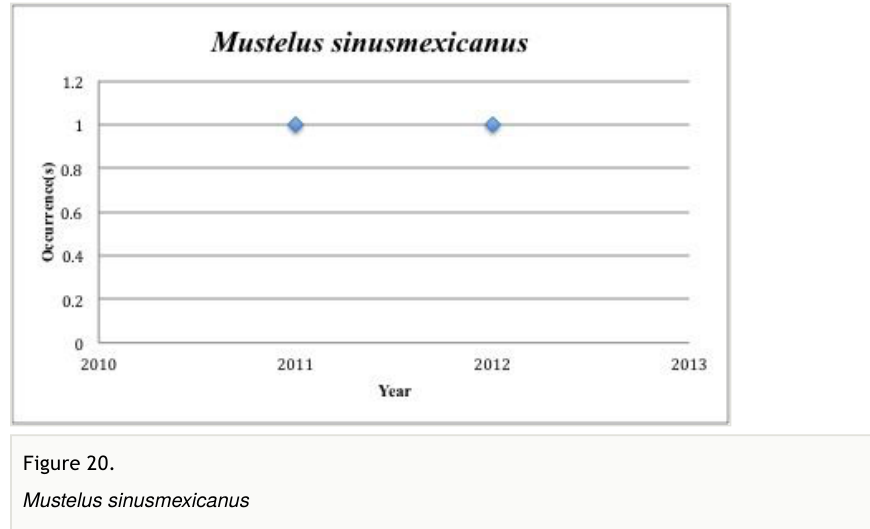
Figure 20. Mustelus sinusmexicanus